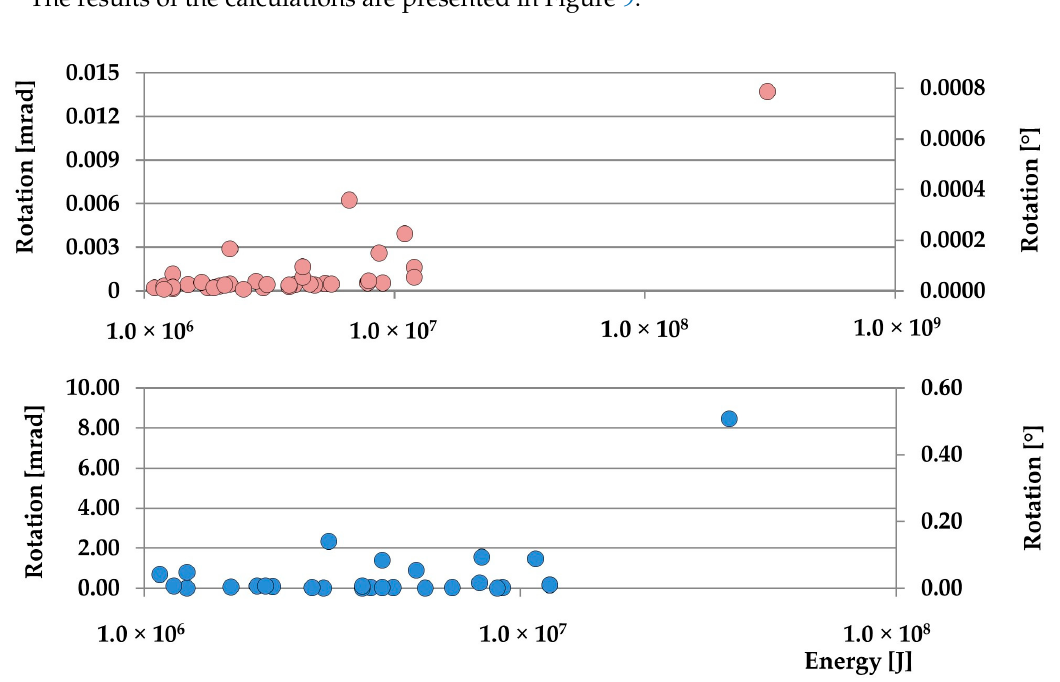
Figure 9 Figure 9. Calculated Peak Ground Rotation ( PG R ) at the slope of Zelazny Most ( top ), and near the base of the Runa-I shaft ( bottom